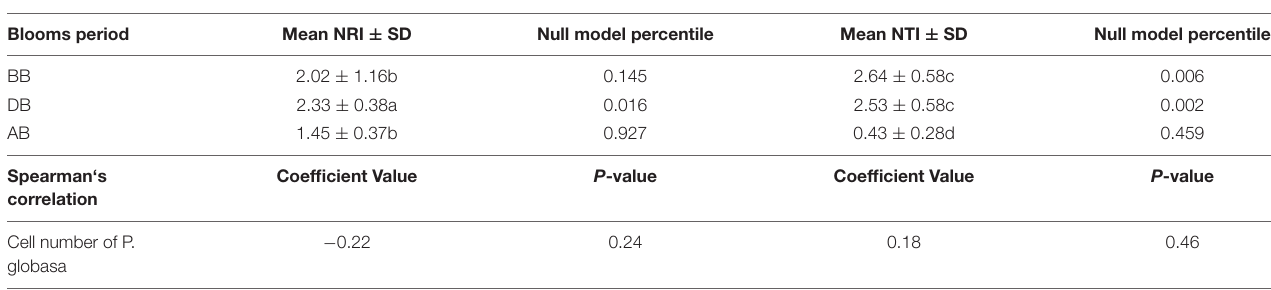
FIGURE 2 | The α -diversity indices in different groups. The differences between pairs of two groups were tested by the Wilcoxon test. ns, not significant. ∗ p < 0.05, ∗∗∗ p < 0.001. BB, before P. globosa blooms; DB, during P. globosa blooms; AB, after P. globosa blooms. TABLE 1 | Phylogenetic relatedness based on NRI and NTI of marine water